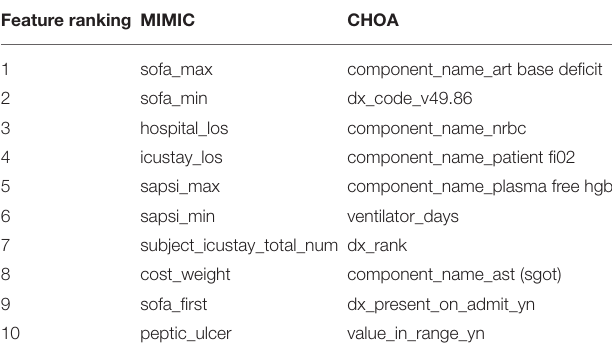
TABLE 5 | Top 10 features in mortality prediction using gradient boosting on Multi-parameter Intelligent Monitoring in Intensive Care (MIMIC) and Children’s Healthcare of Atlanta (CHOA) data.